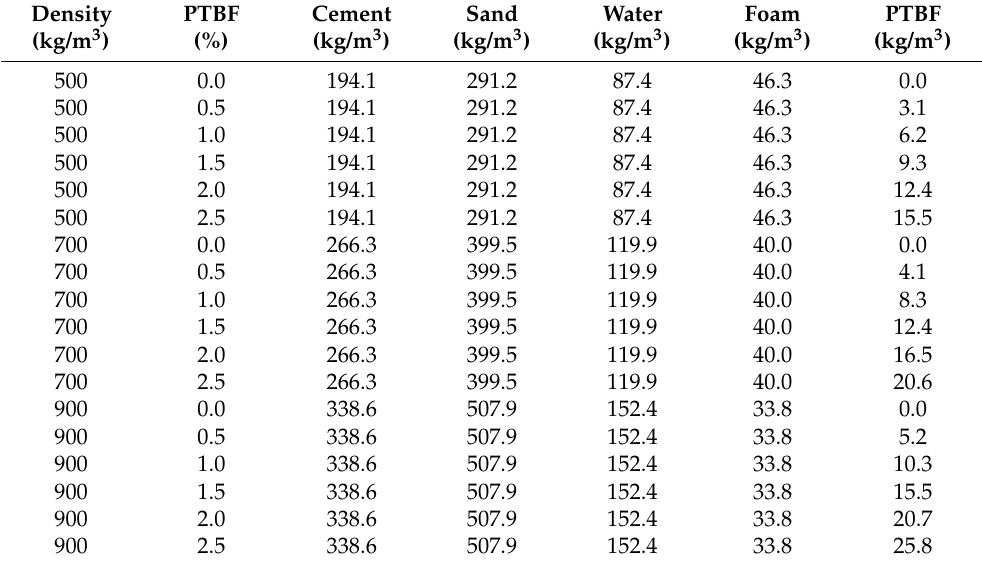
Table 2. Mixture proportions of